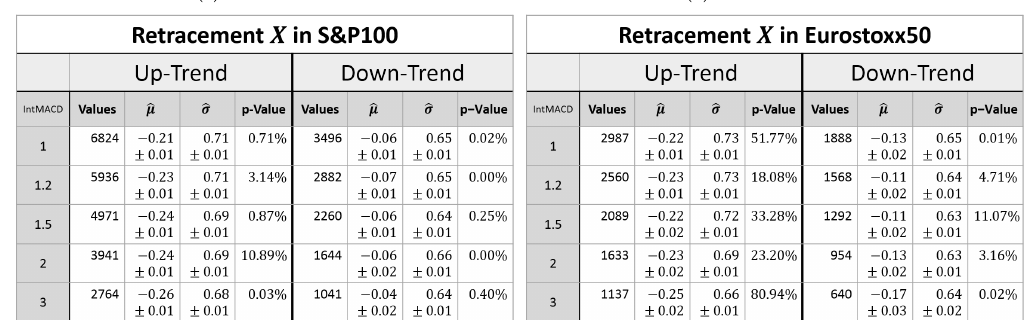
Table 1. Parameters of the log-normal fit for the retracement X in up- and down-trends. ( a ) S&P100 data. ( b ) Eurostoxx50